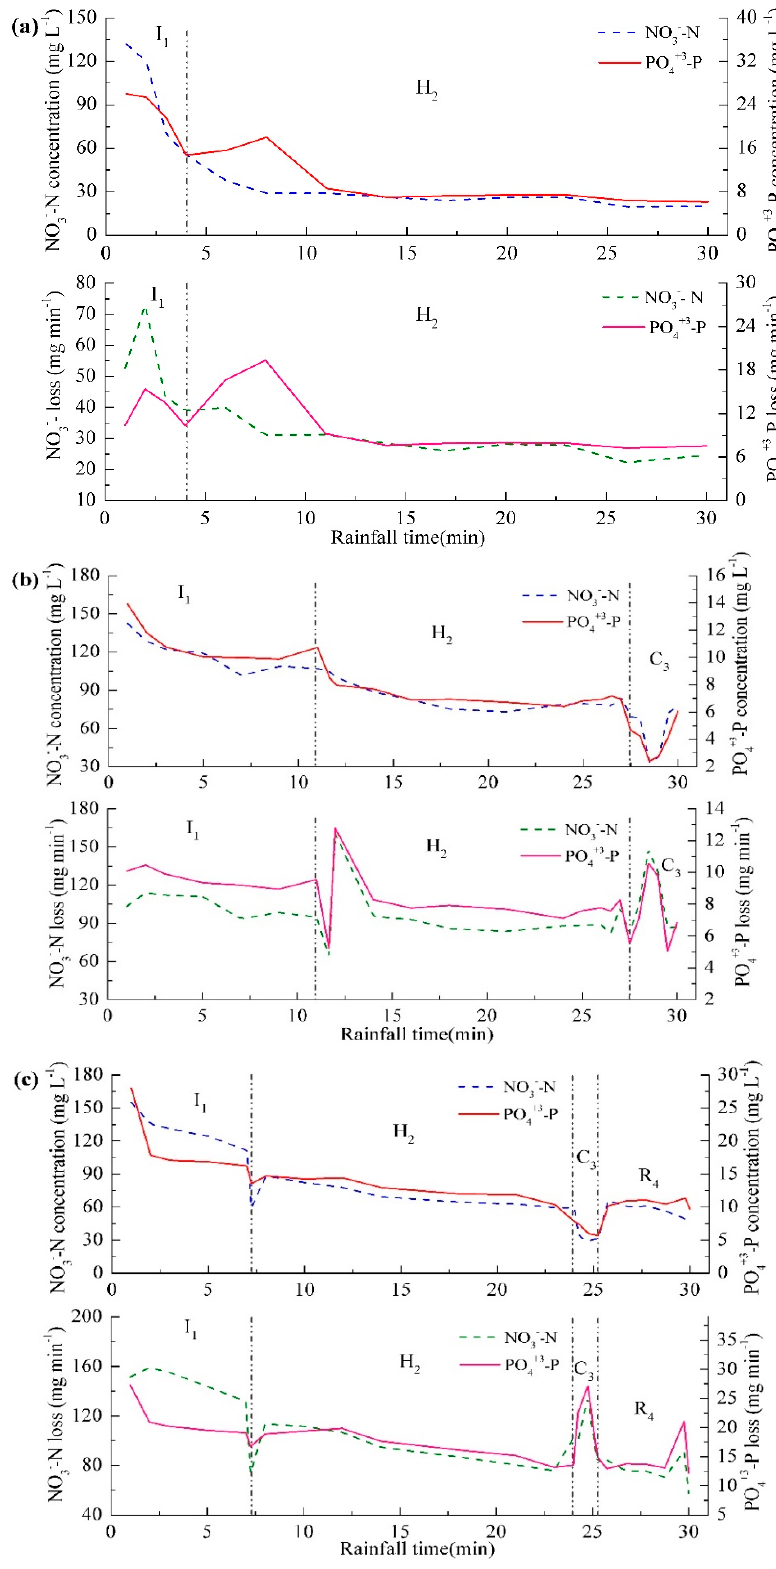
Figure 4. The temporal variation of NO 3 − –N and PO 4+3 –P concentration and loss during rainfall for ( a ) treatment No.13, ( b ) treatment No.16, and ( c ) treatment No.21. I 1 , inter-rill erosion; H 2 , headward erosion; C 3 , contour failure; R 4 , rill erosion.